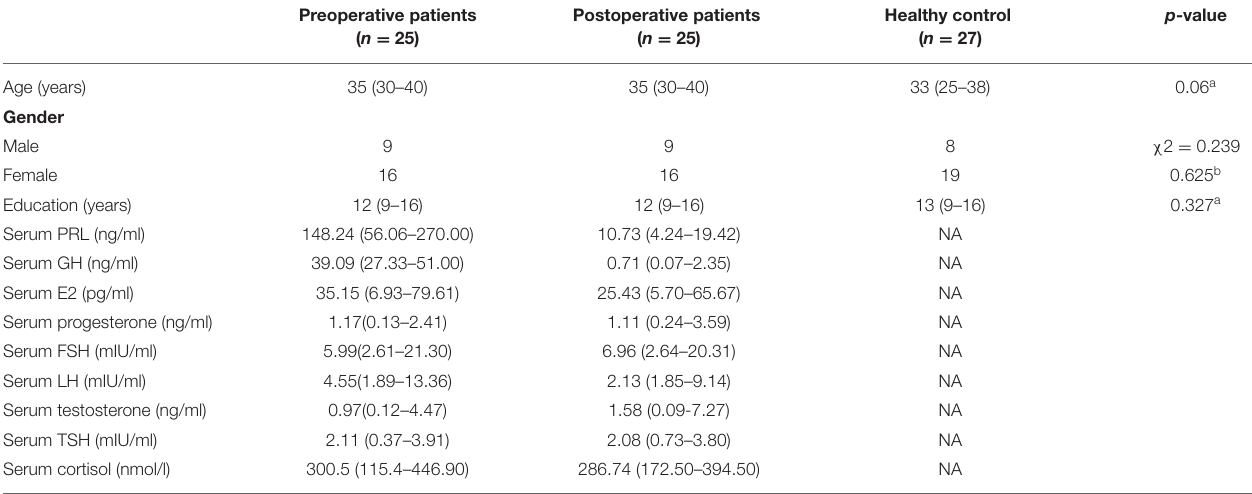
TABLE 1 | Demographic and clinical characteristics: preoperative, postoperative patients and healthy controls.